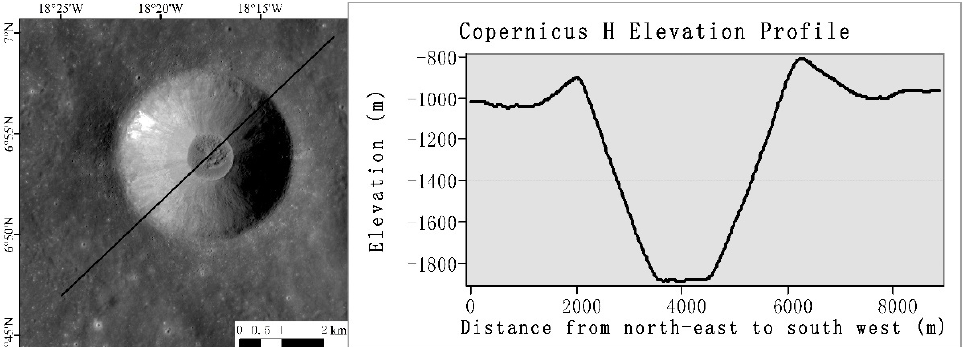
Figure 9. Elevation Profile of Copernicus H from the LOLA-SELENE Kaguya TC DEM.